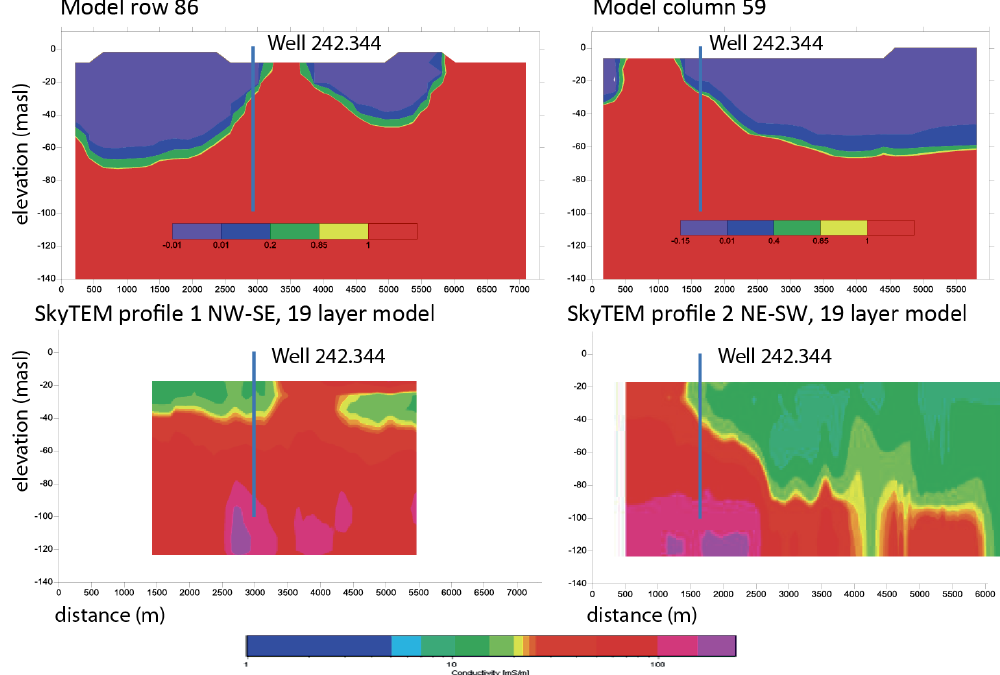
Fig. 9. Comparison between the results of model simulations (upper cross sections) and SkyTEM surveys (lower cross sections). The location of cross sections is indicated on Fig. 6. The colour scales are defined such that blue/green colours indicate freshwater of drinking water quality ([Cl − ] < 250mgL − 1 ). Yellow is breaching a threshold value of 150mgL − 1 , and red breaches the drinking water guideline (Table